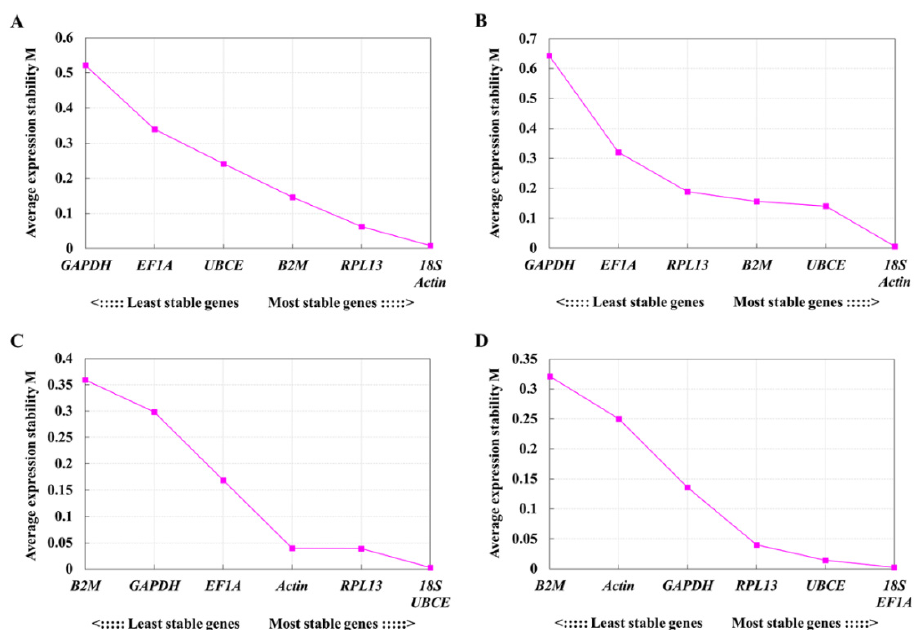
Figure 5. The expression stability of housekeeping gene candidates in GPHK cells under stimulation with LPS for 2 ( A ), 4 ( B ), 8 ( C ) and 12 h ( D ), assessed by geNorm. According to the C t values presented by the seven housekeeping gene candidate stimulations with LPS or PBS, the average expression of stability for housekeeping gene candidates can be evaluated as M by geNorm; not only can the M value not be more than 1.5, but the most reliable housekeeping genes have the most minimal M value as well.